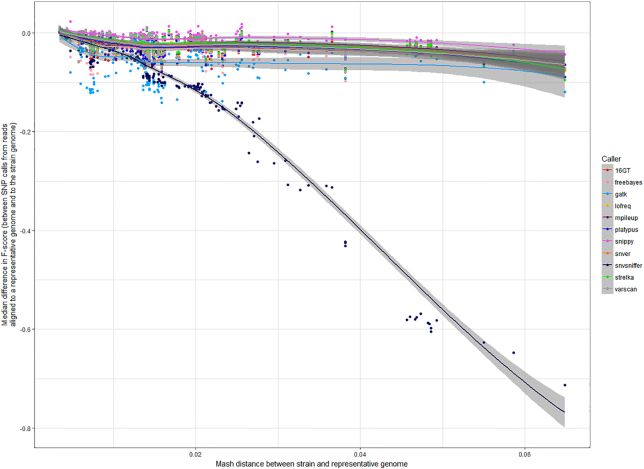
Stability of pipeline performance, in terms of F-score, with increasing genetic distance between the reads and the reference genome. The performance of an SNP-calling pipeline decreases with increasing distance between the genome from which reads are sequenced and the reference genome to which they are aligned. Each point shows the median difference in F-score for a pipeline that calls SNPs when the reference genome is the same as the source of the reads, and when it is instead a representative genome for that species. Points are coloured according to the variant caller in each pipeline, with those towards the top of the figure less affected by distance. Lines fitted using LOESS smoothing, with the grey band representing the 0.95 confidence interval.